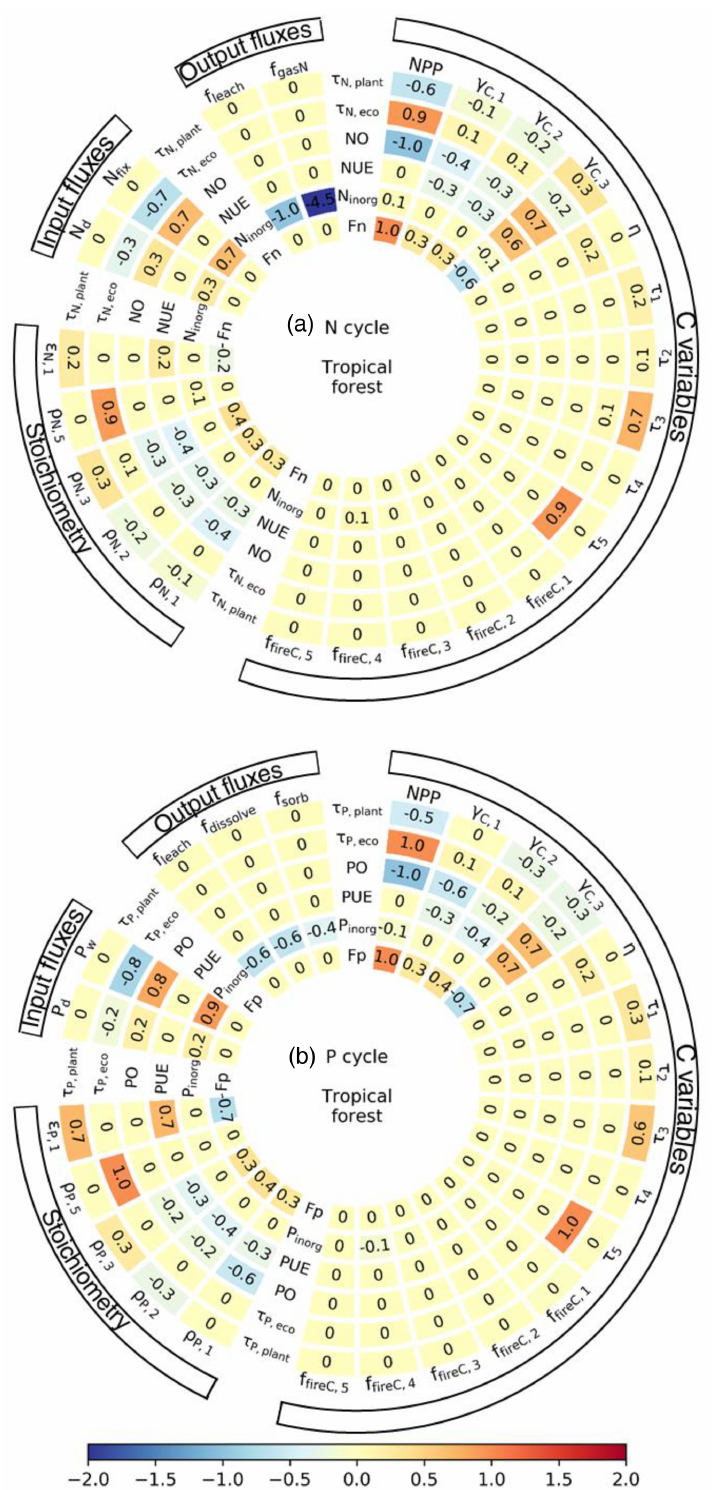
Figure 8. Mean sensitivity of the estimates of rates of nutrient uptake, inorganic nutrients, nutrient-use efficiencies, openness, turnover time of nutrients in the ecosystem, and turnover time of nutrients in plants to the input variables for tropical forest. Results for other biomes are shown in Figs.